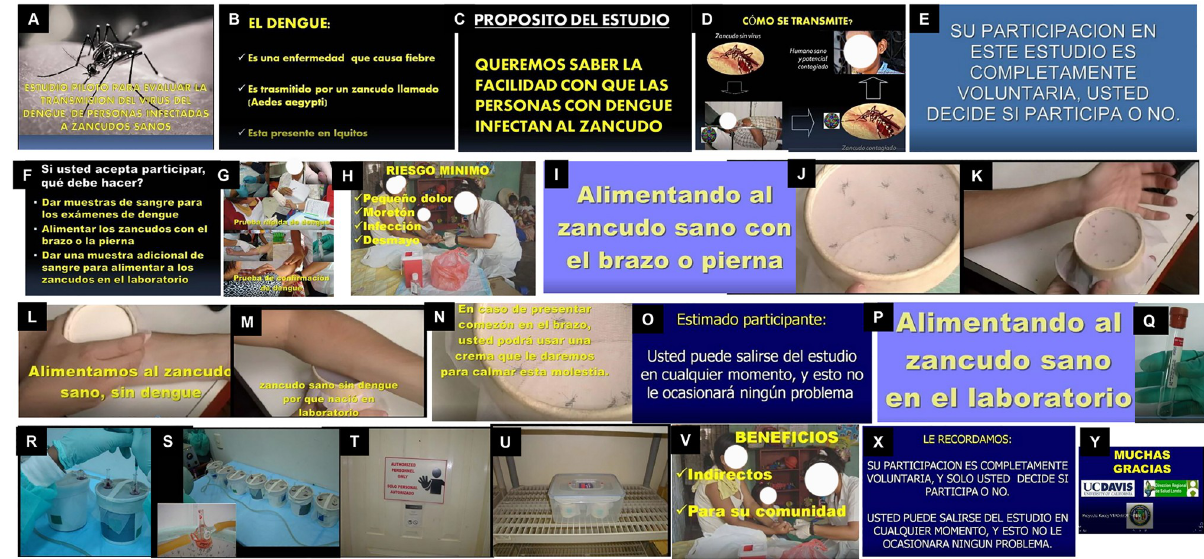
Fig 1. Key screen shots from mosquito feeding consent video. (A) Project Title. Pilot study to evaluate the transmission of dengue virus from infected people to healthy mosquitoes. (B) Simple information on dengue. (C) Study objective. We want to know how easily people with dengue can infect mosquitoes. (D) Dengue transmission cycle. (E) Disclaimer. “Your participation is completely voluntary, you decide to participate or not. (F) Participation included a blood sample to findout if you have dengue, feeding mosquitoes with your arm or leg, and given more blood when you feed the mosquitoes. (G) Taking blood samples. (H) Risks. pain, bruise, infection, fainting. (I) Feeding healthy mosquitoes. (J-M) Feeding healthy mosquitoes, without dengue that were grown in the laboratory. (N) Providing itch cream if needed. (O) Disclaimer, (P-S) Feeding mosquitoes in the laboratory. (T-U) Storing the mosquitoes safely. (V) Study benefits. (X) Disclaimer. (Y) Thank